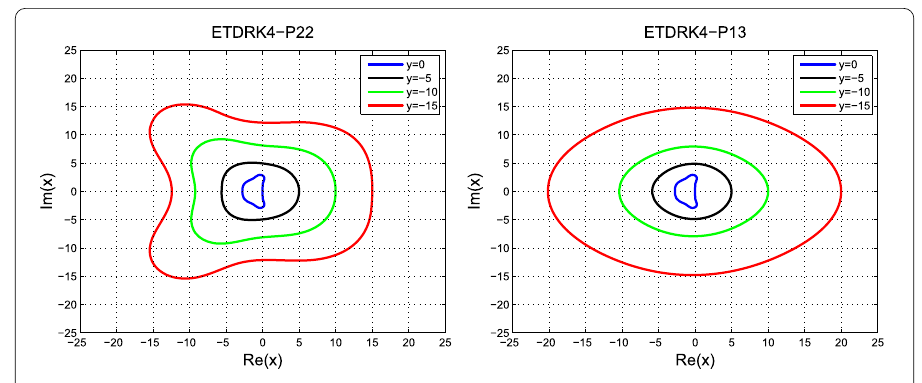
Figure 3 Stability regions of the ETDRK4-P22 and ETDRK4-P13 schemes for different y